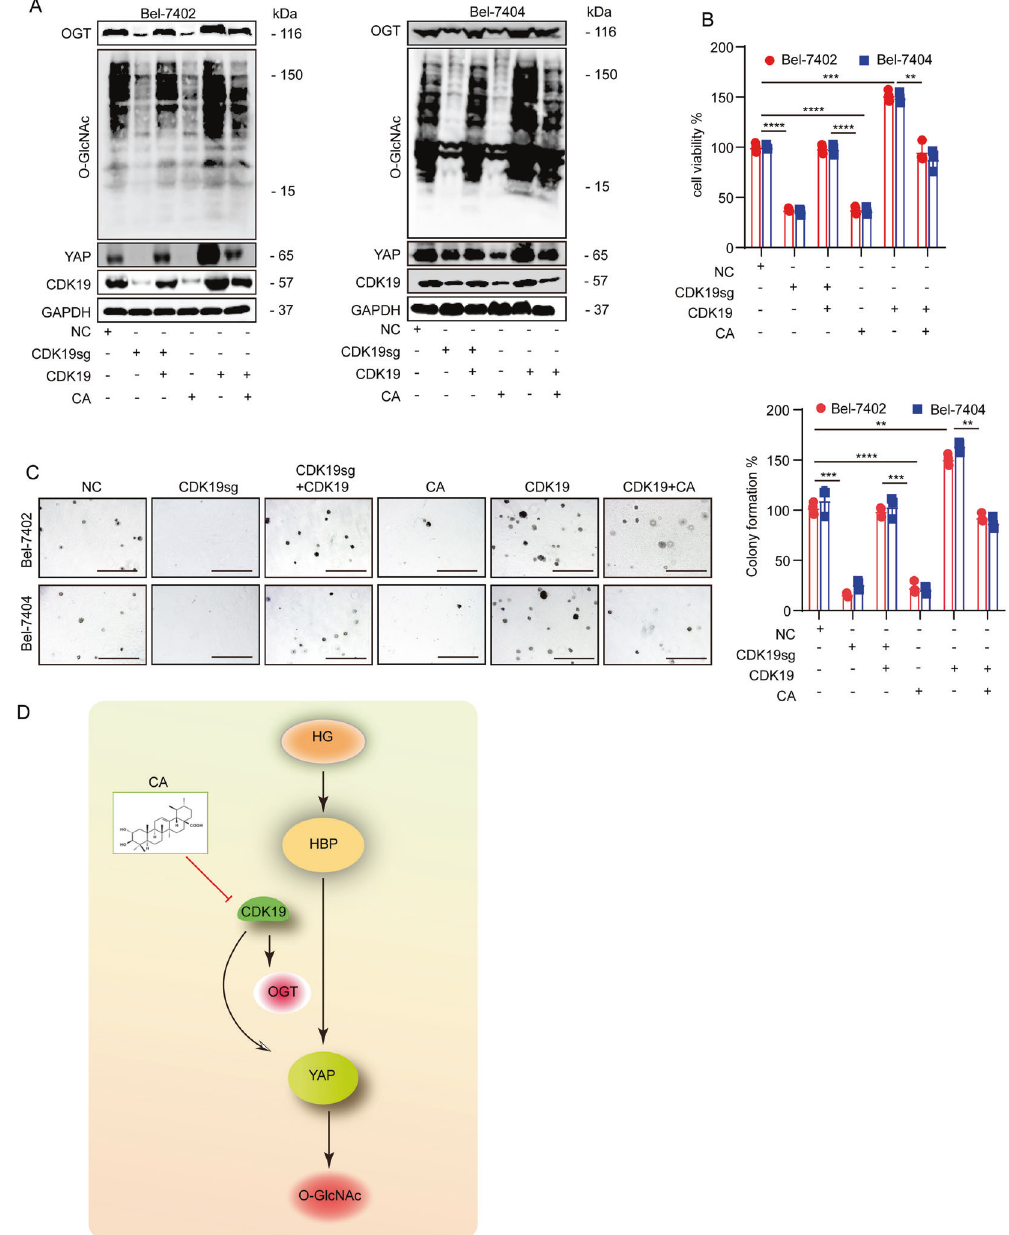
Fig. 7 A The protein expression of OGT, O -GlcNAc, YAP, CDK19, and CDK8 was analyzed by WB in cells subjected to the indicated treatments. B , C Cell proliferation and colony-formation capacity were measured with CCK-8 cytotoxicity tests ( B ) and soft agar colony-formation assays ( C ), respectively, in Bel-7402 and Bel-7404 cells subjected to different treatments as indicated. D The possible mechanism of CA to inhibit diabetes-associated liver cancer. Data are shown as mean ± SD. ** P < 0.01, *** P < 0.001, **** P <